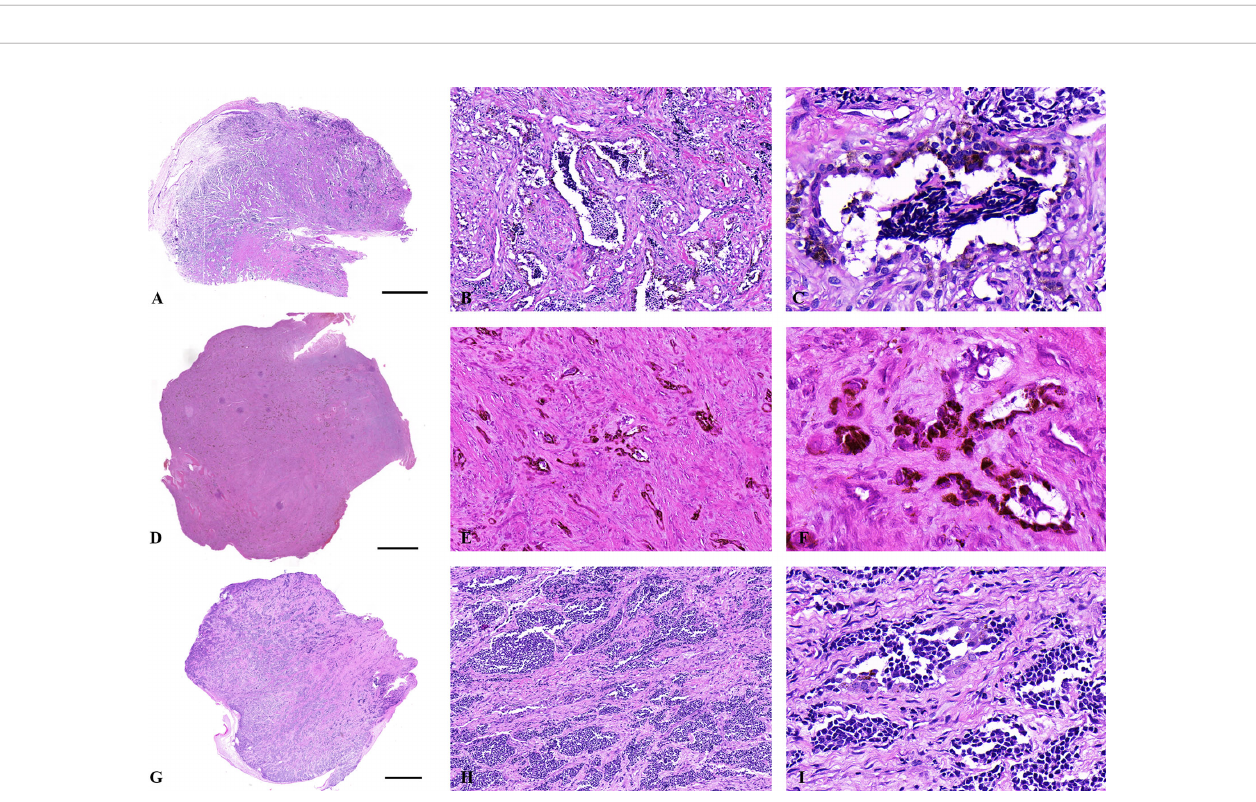
FIGURE 2 | Histological features of MNTIs. (A – C) The tumor was consisted of two types of cells which arranged in irregular alveolar, tubuloglandular and fi ssured architecture, with cords and strands intersected by dense fi broblastic stroma. (D – F) this case was predominant with large melanin-producing epithelioid cells. (G – I) this case was predominant with small neuroblast-like cells. Hematoxylin-Eosin staining. Scale bar: 2000 m m. (B, E, H) x100. (C, F, I) x400.